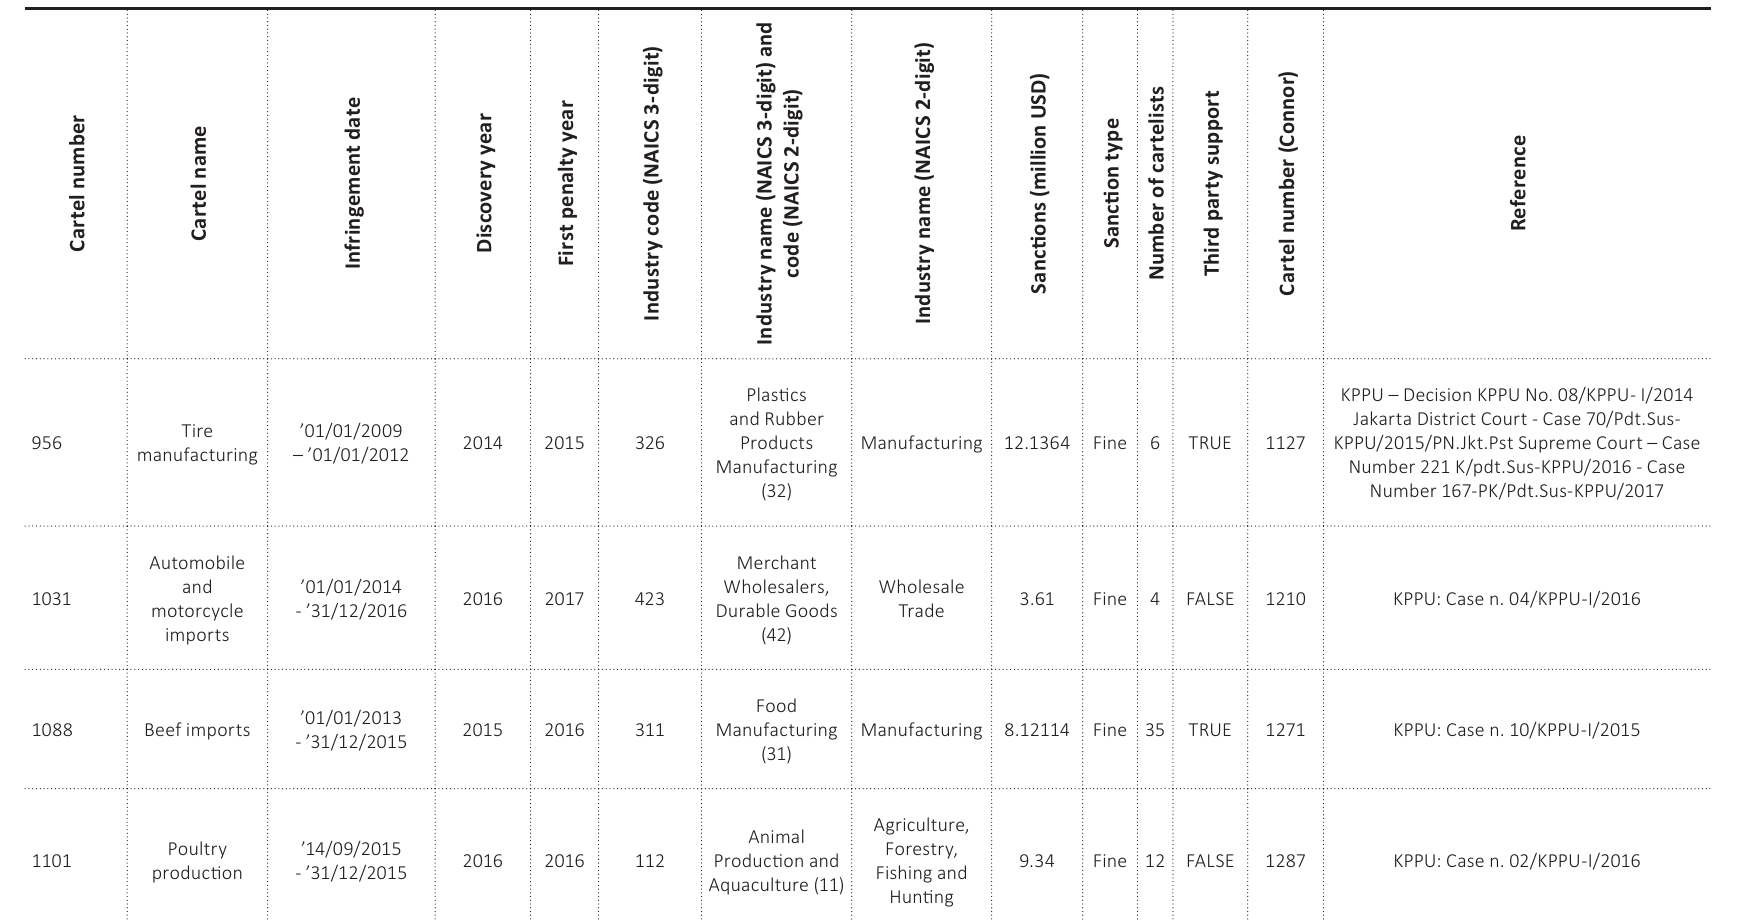
Table 2. Cartel information in